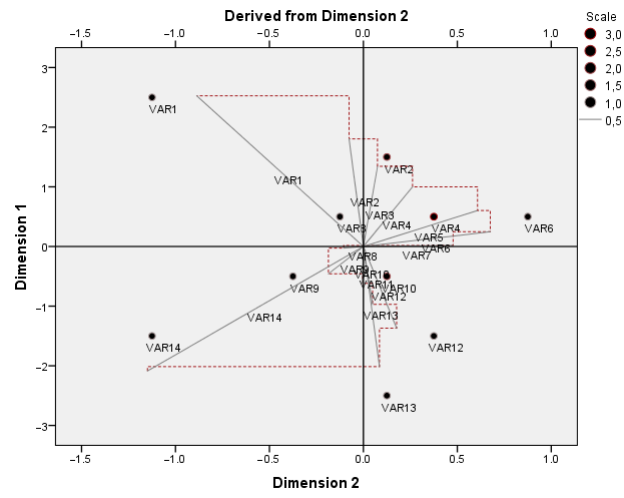
Figure 10. Proximity matrix (Euclidean distance between